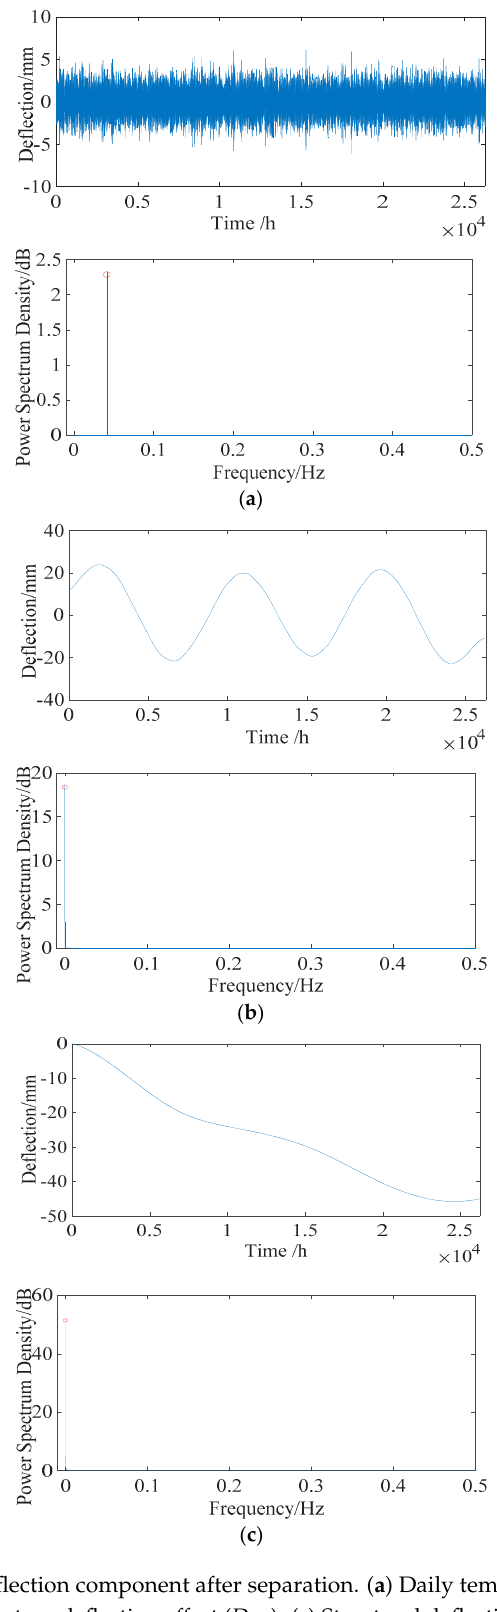
Figure 13. Individual deflection component after separation. ( a ) Daily temperature deflection effect ( D T 1 ). ( b ) Annual temperature deflection effect ( D T 2 ). ( c ) Structural deflection D V (including D S , D C , and D P ).